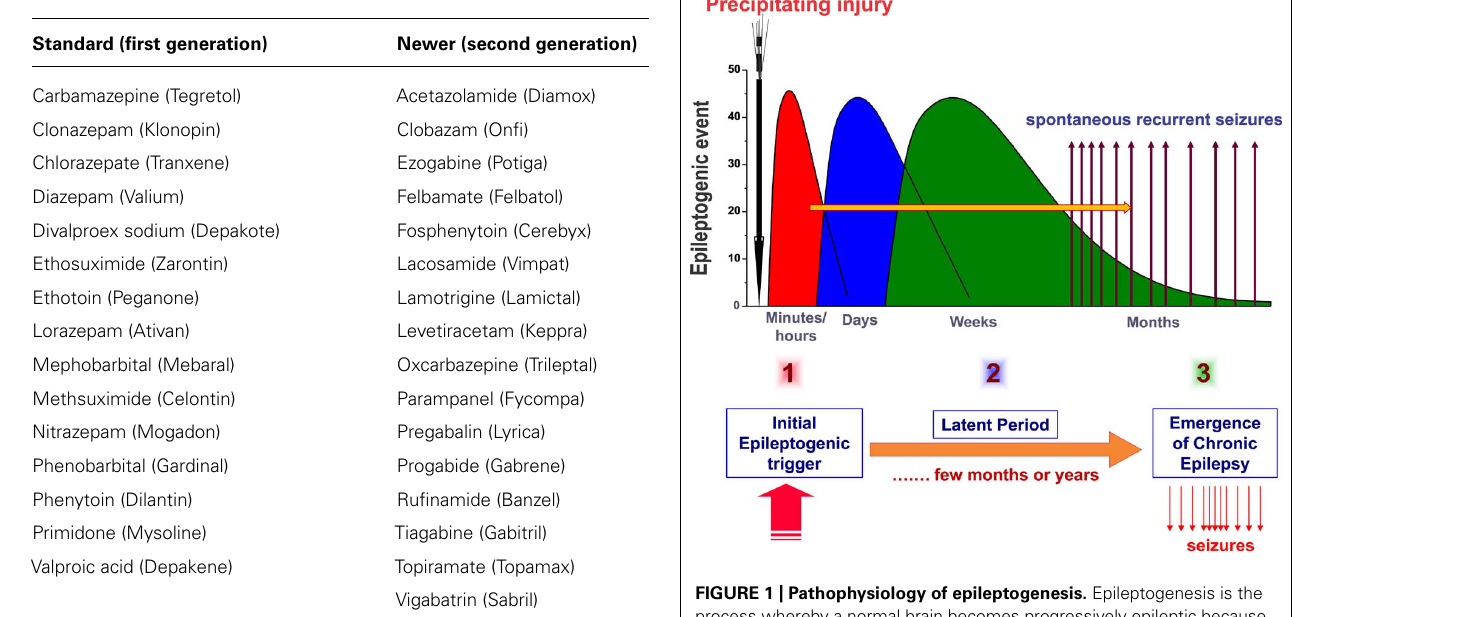
FIGURE 1 | Pathophysiology of epileptogenesis. Epileptogenesis is the process whereby a normal brain becomes progressively epileptic because of precipitating injury or risk factors such asTBI, stroke, brain infections, or prolonged seizures. Epilepsy development can be described in three stages: (1) the initial injury (epileptogenic event); (2) the latent period (silent period with no seizure activity); and (3) chronic period with spontaneous recurrent seizures. Although the precise mechanisms underlying spatial and temporal events remain unclear, epileptogenesis may involve an interaction of acute and delayed anatomic, molecular, and physiological events that are both complex and multifaceted.The initial precipitating factor activates diverse signaling events, such as inflammation, oxidation, apoptosis, neurogenesis, and synaptic plasticity, which eventually lead to structural and functional changes in neurons.These changes are eventually manifested as abnormal hyperexcitability and spontaneous